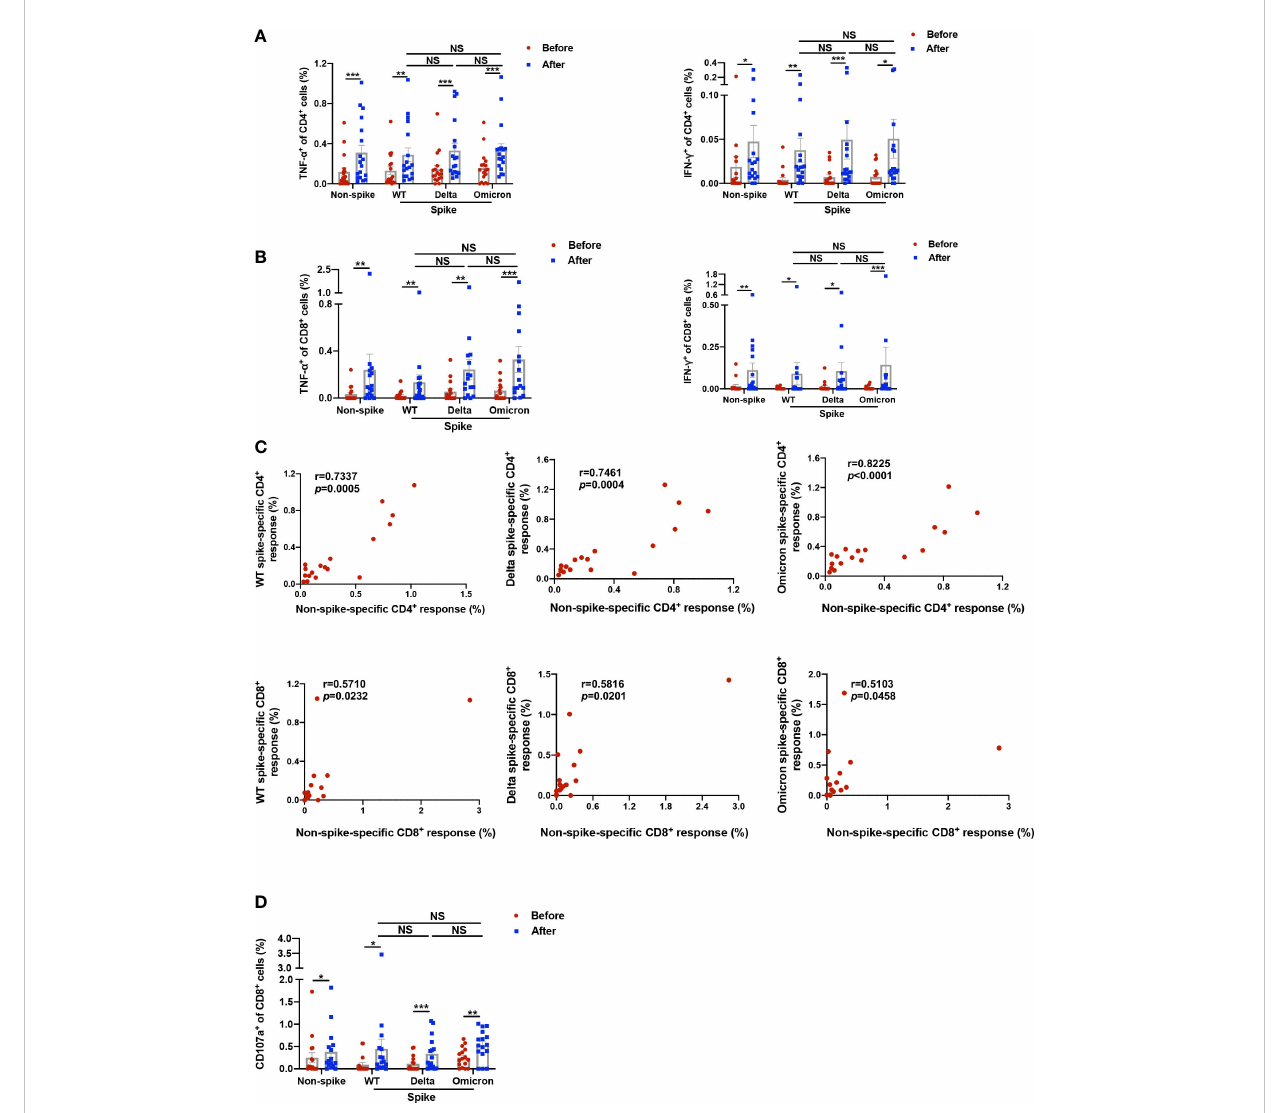
FIGURE 2 Functional analysis of non-spike and spike-speci fi c CD4 + and CD8 + T cell responses. PBMCs obtained before and 1-2 weeks after the third dose of CoronaVac were stimulated with spike peptide pools from WT, Delta, and Omicron as well as a non-spike peptide pool from WT SARS-CoV-2 for 20 h. (A – C) TNF- a and IFN- g -producing CD4 + and CD8 + T cells in response to non-spike and spike peptides were detected by intracellular cytokine staining. (A) Data showed percentages of TNF- a and IFN- g -producing CD4 + T cells against non-spike and spike peptides. (B) Data showed percentages of TNF- a and IFN- g -producing CD8 + T cells against non-spike and spike peptides. (C) Cytokine-secreting CD4 + and CD8 + T cells against non-spike and spike peptides after the booster dose were calculated by aggregating amounts of TNF- a and IFN- g -producing CD4 + /CD8 + T cells, including TNF- a + IFN- g - , TNF- a + IFN- g + , and TNF- a - FN- g + . Correlation analysis curve was plotted by the percentage of cytokine-secreting non- spike-speci fi c CD4 + and CD8 + cells to their corresponding percentage of spike-speci fi c CD4 + and CD8 + cells from WT, Delta, and Omicron. r, correlation coef fi cient. (D) Data showed percentages of CD107a + CD8 + T cells against non-spike and spike peptides determined by fl ow cytometry. Each point represents raw data for a single participant. Percentages show the percentage of T cells after subtracting the background value in a DMSO stimulation. Comparisons were performed via Wilcoxon matched-pairs signed rank test between two groups or Friedman test with Dunn ’ s multiple comparisons test among multiple groups. Correlation analysis was performed via nonparametric spearman correlation. n = 16 - 18. * p < 0.05, ** p < 0.01, *** p < 0.001. NS, not signi fi